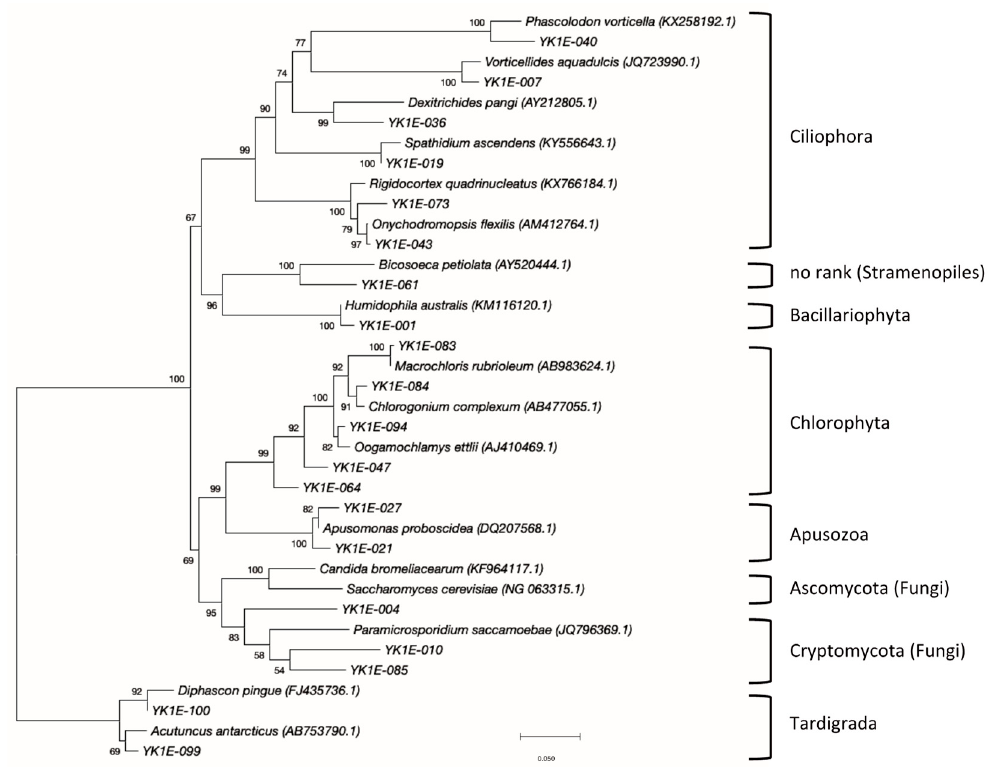
Figure 9. Phylogenetic tree of eukaryal clones. The DNA database accession numbers for described species are in parentheses. The bar indicates evolutionally distance. The bootstrap value of each node is indicated.